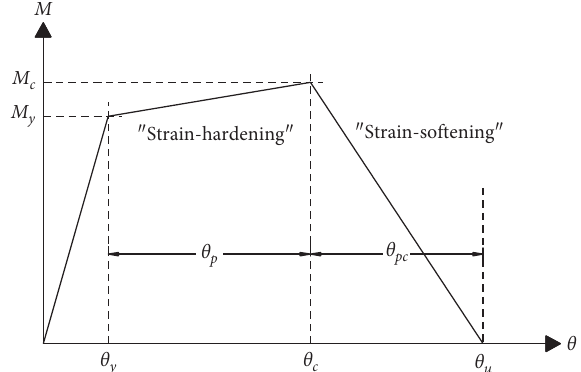
Figure 2: Monotonic backbone curve for reinforced concrete